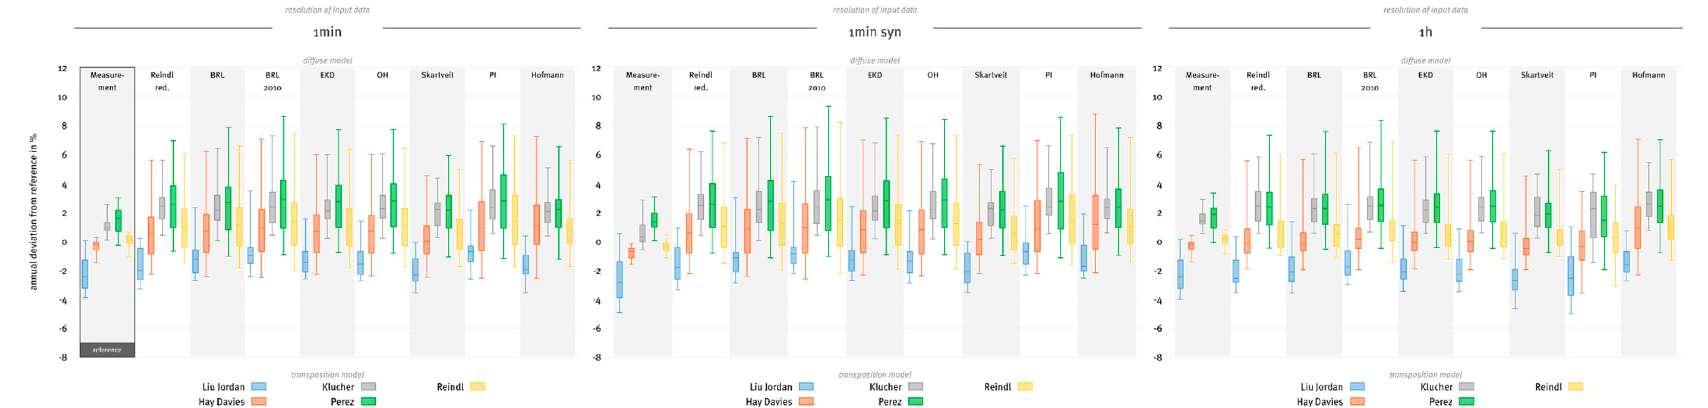
Figure A1. The annual deviation of the modeled PV energy from the reference model chain, grouped by diffuse fraction model, transposition model and input data type. The reference is calculated from the output of the model chains that contain one-minute measurement data for both global and diffuse irradiation (black frame). Each box and whisker contains results from 30 locations.